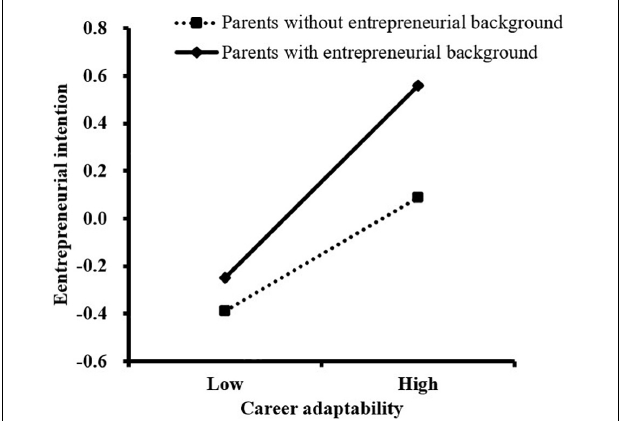
FIGURE 3 | The moderating effect of parental entrepreneurial background on the relationship between career adaptability and entrepreneurial